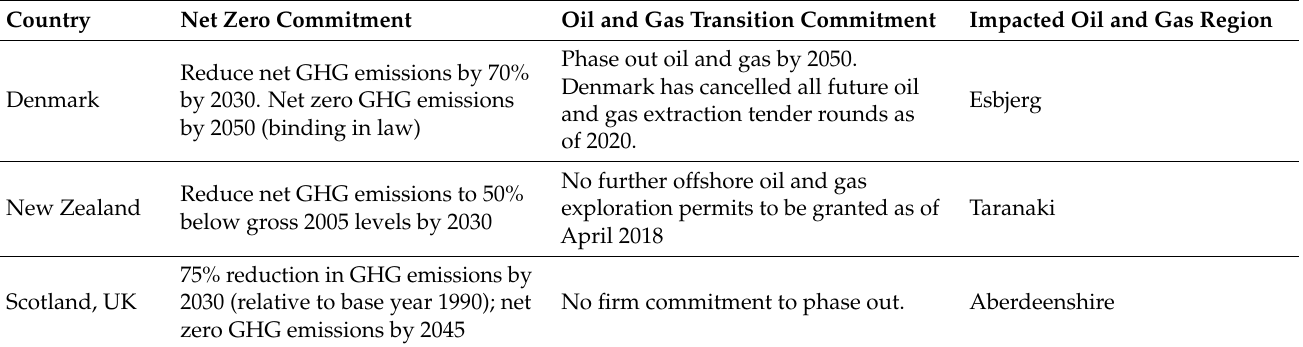
Table 1. Case study